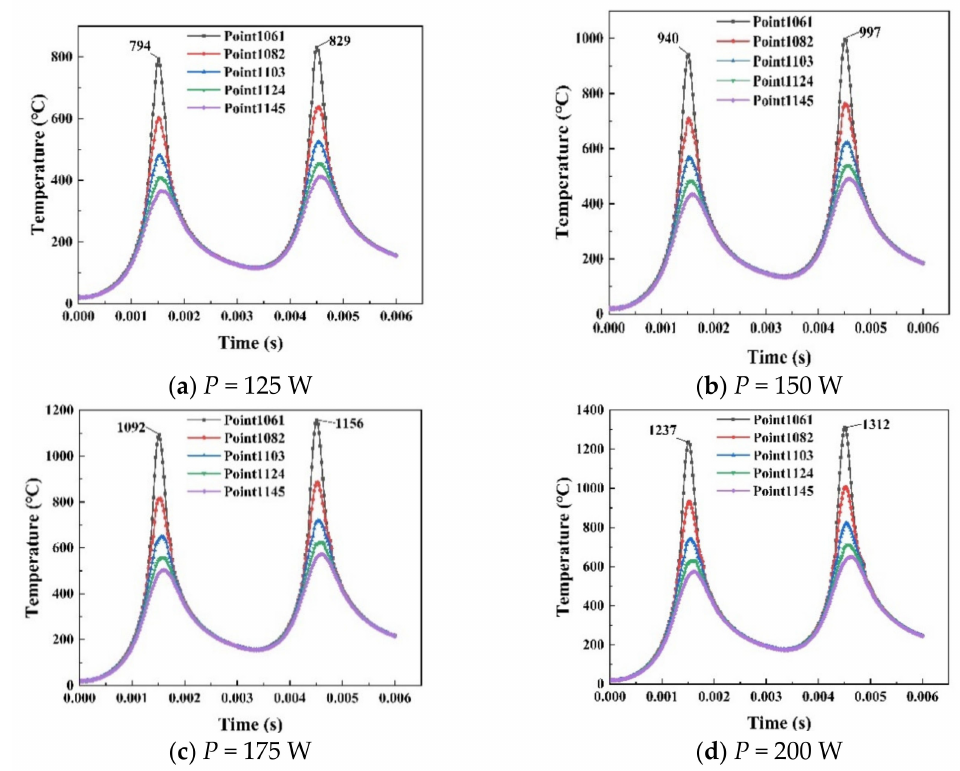
Figure 5. Midpoint temperature distribution curve of two scanning tracks with different powers ( a ) P = 125 W ( b ) P = 150 W ( c ) P = 175 W ( d ) P = 200 W.